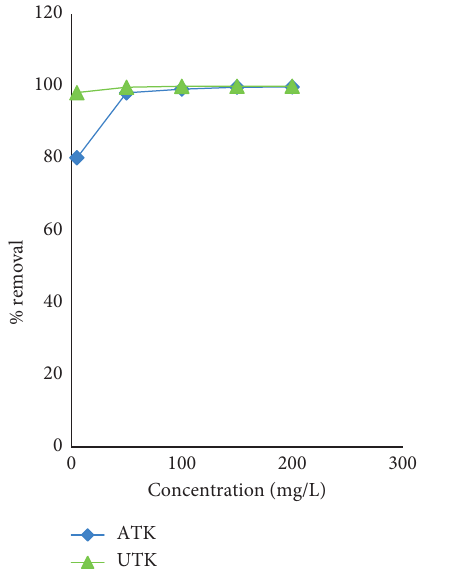
Figure 6: % removal of Cd (II) ions versus concentrate.